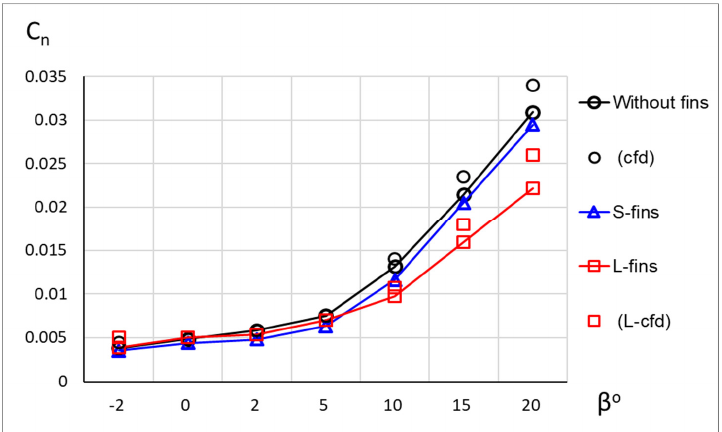
Figure 13. Yaw moment coefficient of the initial model versus the model equipped with small (S) and large (L) vertical fins. Results are provided from both wind tunnel experiment and CFD for validation.